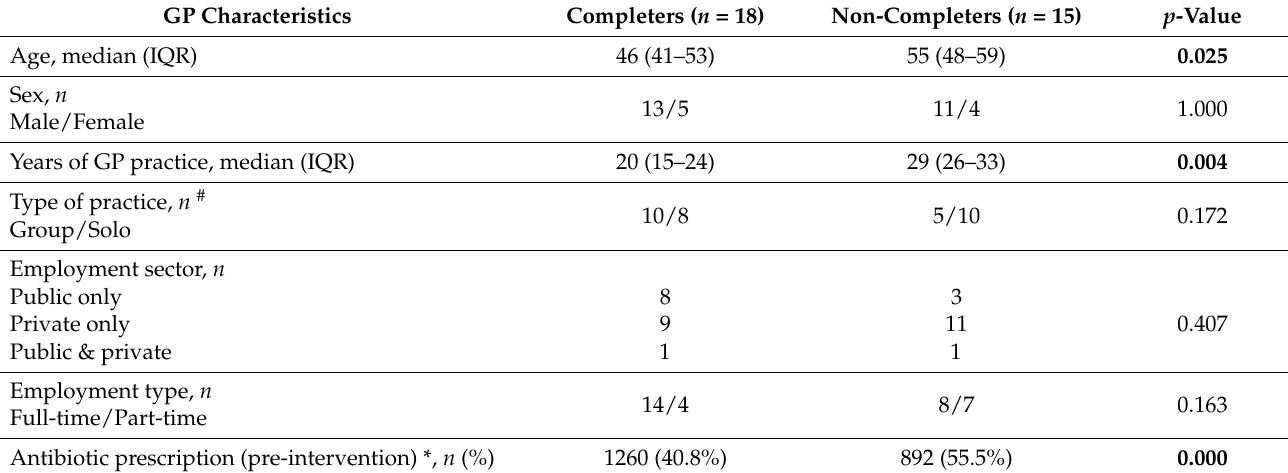
Table 2. Comparison of general practitioners’ characteristics: ‘completers’ versus